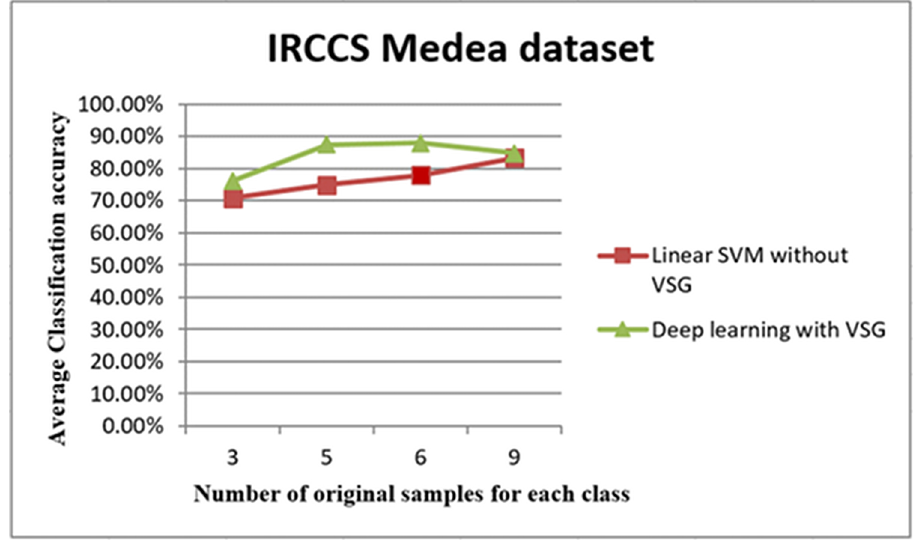
Figure 8. The trend of average accuracy using the IRCCS dataset. The line graph in Figure 8 shows the comparison between the performance of linear SVM without Virtual Sample Generation (VSG) and deep learning with the VSG number in the IRCCS Medea dataset. The x -axis of this graph shows the original samples for each class that were used to generate the virtual sample in deep learning and the training sample for linear SVM, while the average of the classification accuracy is the y